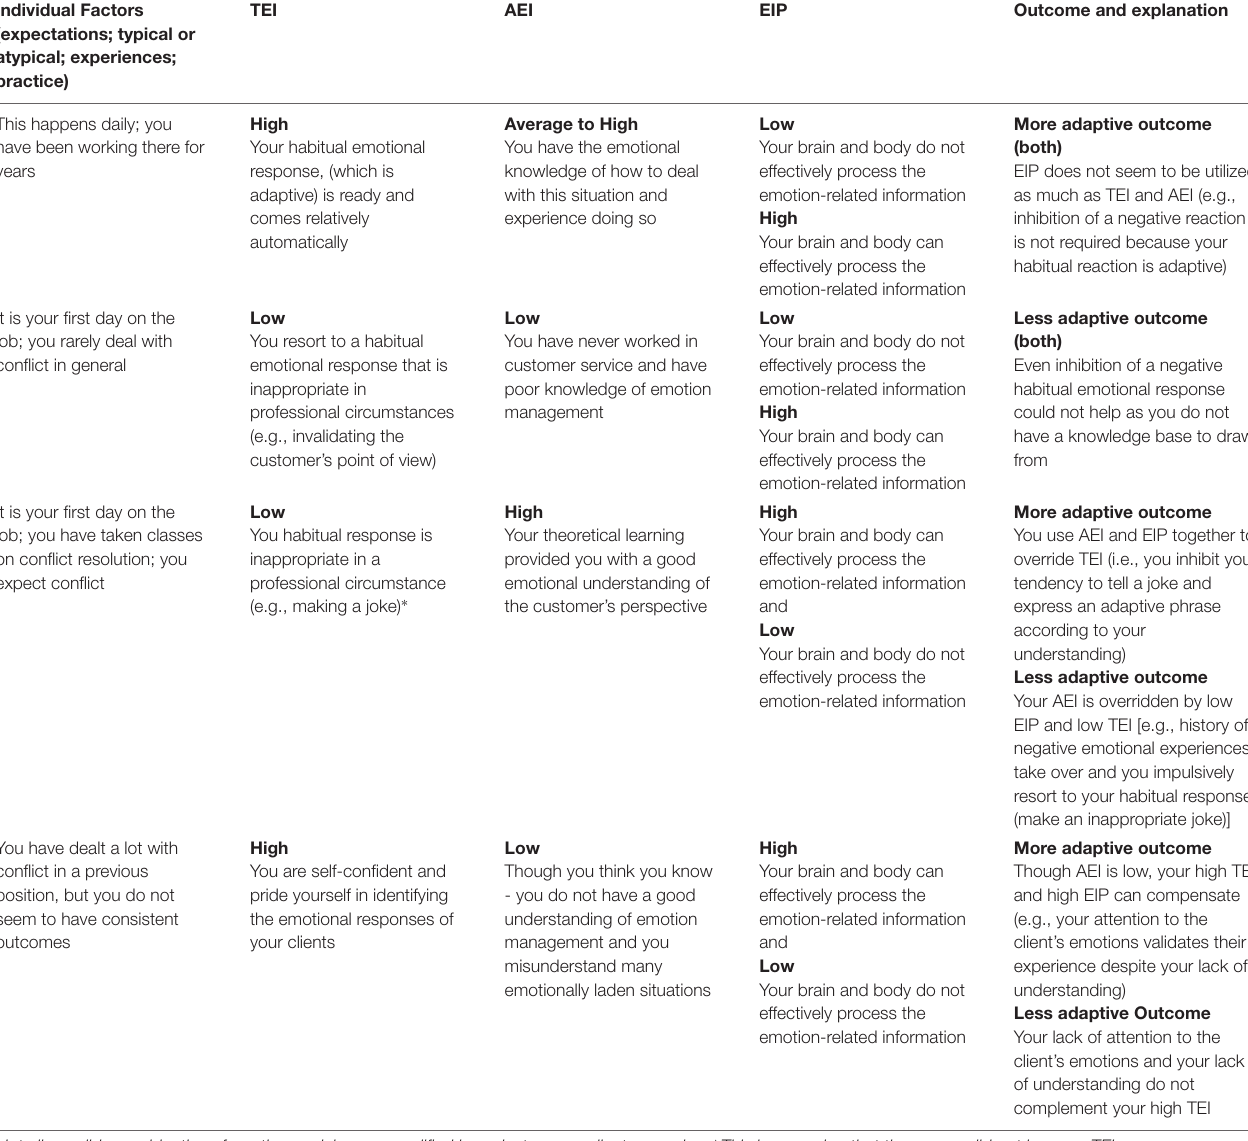
TABLE 3 | Hypothetical examples of EI interactions. Individual Factors TEI AEI EIP Outcome and (expectations; typical or atypical; experiences; practice)